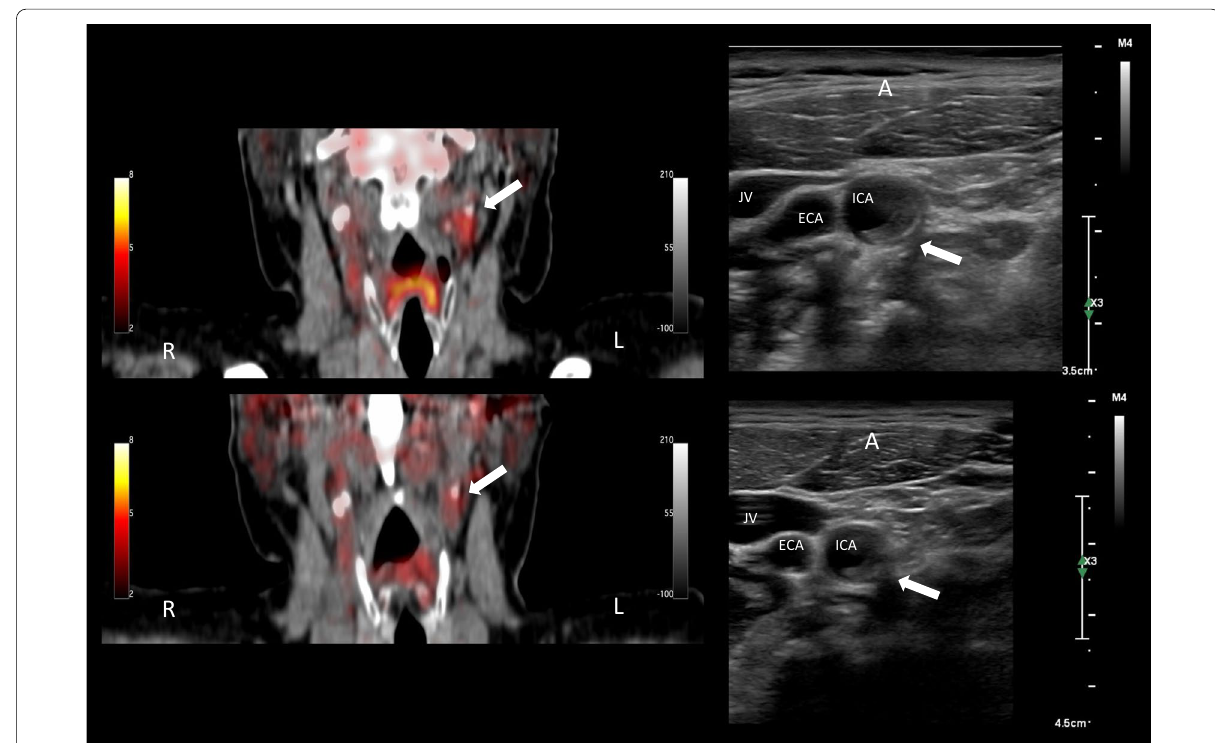
Fig. 4 Baseline and follow-up patient example of 2-[18F]FDG-PET / CT-angiography and ultrasound images. Images from one patient. To the left 2-[18F]FDG-PET/CT angiography fusion, frontal MPR and to the right ultrasound images, axial plane. The top images are from baseline and the bottom follow-up. The white arrow points to the plaque on the symptomatic